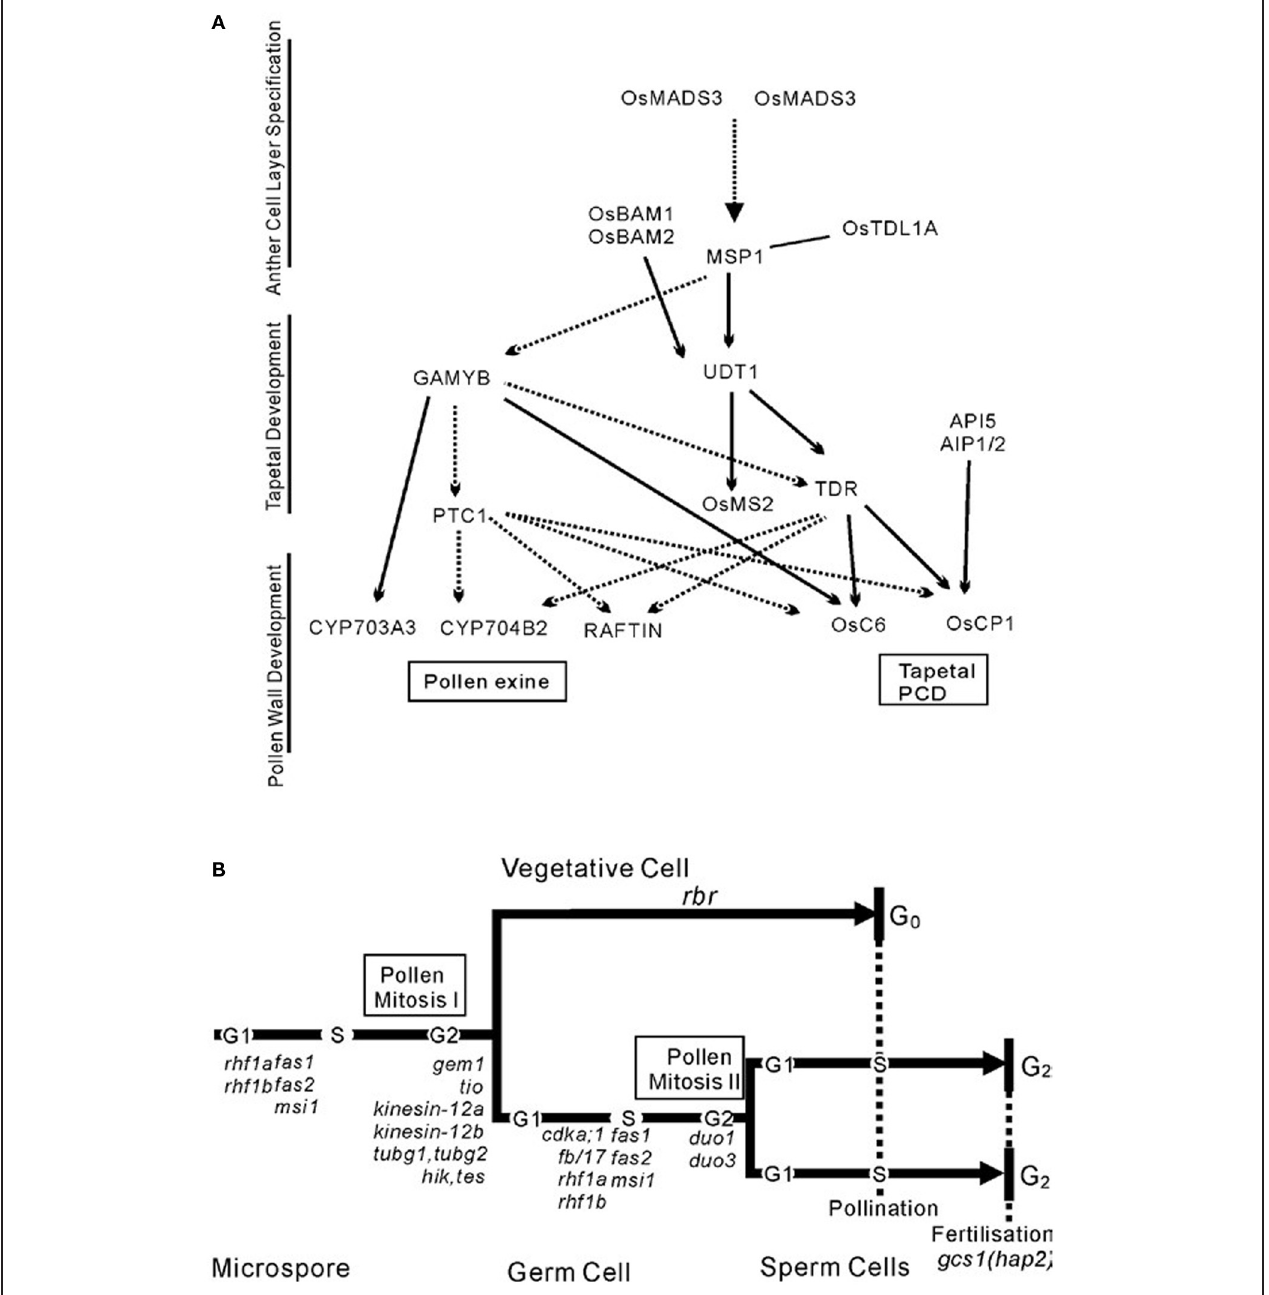
FIGURE 3 | Two local pathways of development of the male reproductive system. (A) The networks of pollen development in rice. (B) Schematic illustrating the cell lineages and cell cycle progression in microspore